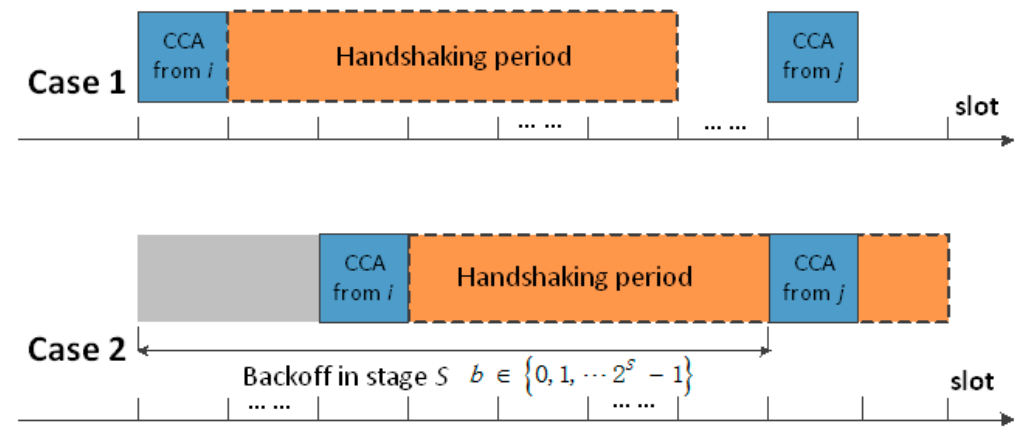
Figure 1. Two kinds of successful clear channel assessments (CCA) processes.